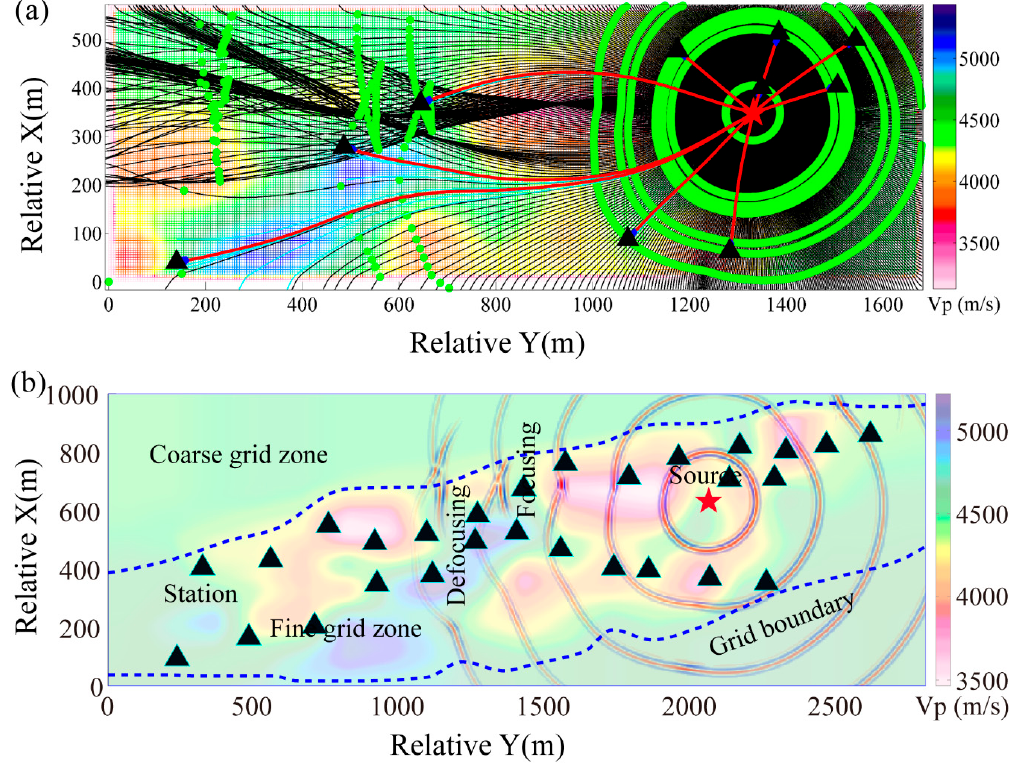
Figure 4. Ray propagation paths of the shooting method and schematic diagram of wavefield propagation by the spectral element method (SEM) modeling. ( a ) Ray propagation paths of the shooting method (modified from Wang et al. [6]). The background is a 2D sliced plane of the 3D velocity model, which is determined through the least square vertical distance from all sensors to the plane. The black triangles represent the sensor locations, and the red star denotes the source location. The black thin curves are ray propagation paths from different angles of the source, the red lines are ray propagation paths from the source to each sensor, and the green curves are the wavefronts; ( b ) Schematic diagram of wavefield propagation by SEM modeling. The time interval between adjacent wavefronts is 0.004 s, and the wavefield amplitude is globally normalized to show the attenuation, focusing, and defocusing characteristics of wavefield propagation in complex media. The dotted line shows the boundary of the fine grid region. 4.2. Case of Waveform Modeling and Source-Time Function Estimating Taking the black star in Figure 4 as the source location and setting the source as an explosion source, and considering that the main frequency of a blasting event is usually within 250 Hz and the dominant frequency is usually within 120 Hz, a Ricker wavelet with dominant frequency 120 Hz is taken as the source-time function for SEM modeling. The time interval between adjacent wavefronts shown in Figure 4 is 0.004 s. It can be seen that the SEM method can precisely model the focusing and defocusing effects in complicated velocity regions compared with the ray tracing technique (Figure 1 in [6]): The low-velocity regions have focusing effects on the transmitted waves and produce diffraction and multi-path effects. There are defocusing effects on waves propagating through the high-velocity regions, which are usually difficult to rapidly and appropriately calculate travel-time field of waves passing through the strong high-velocity regions by using the ray-shooting method. In addition, the wavefield attenuates rapidly with the increase of propagation distance, indicating that the SEM modeling can correctly consider the variation of waveform amplitude so as to make full use of information contained in the observed waveforms.